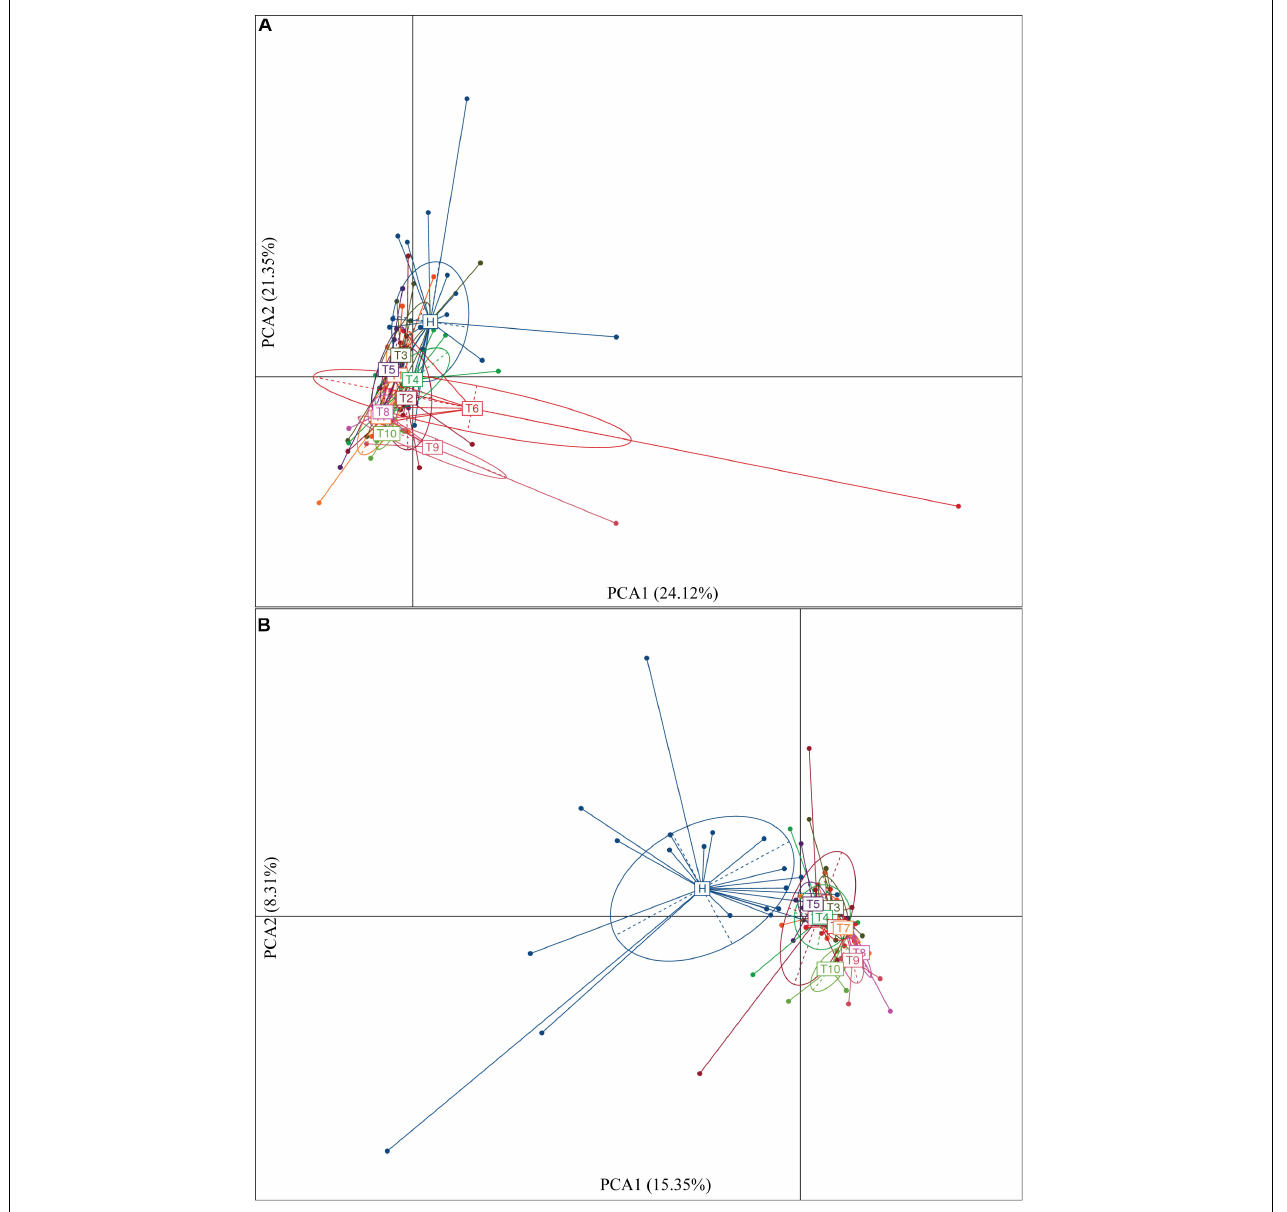
FIGURE 4 | Significantly different genera (A) and OTUs (B) based on the PCA plot between healthy individuals and NSCLC patients in response to osimertinib